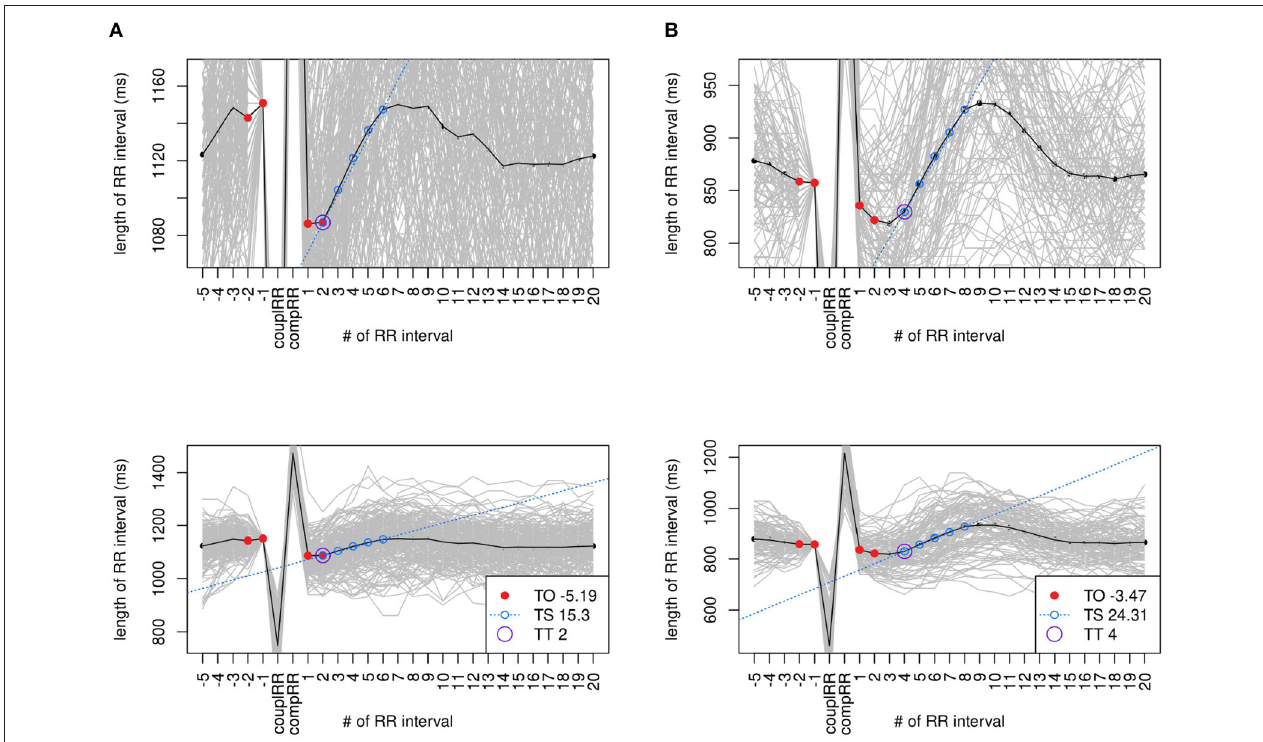
FIGURE 2 | Standard VPCS (stVPCS) files with distinct heart rate turbulence (HRT). Exemplary tachograms of two files used to calculate the stVPCS that show distinct HRT. Both files are in class HRTA. The upper row shows a zoomed in tachogram, the row below the respective tachogram zoomed out. Data: (A) e145a from CRISDB and (B) nsr010 from NSR2DB